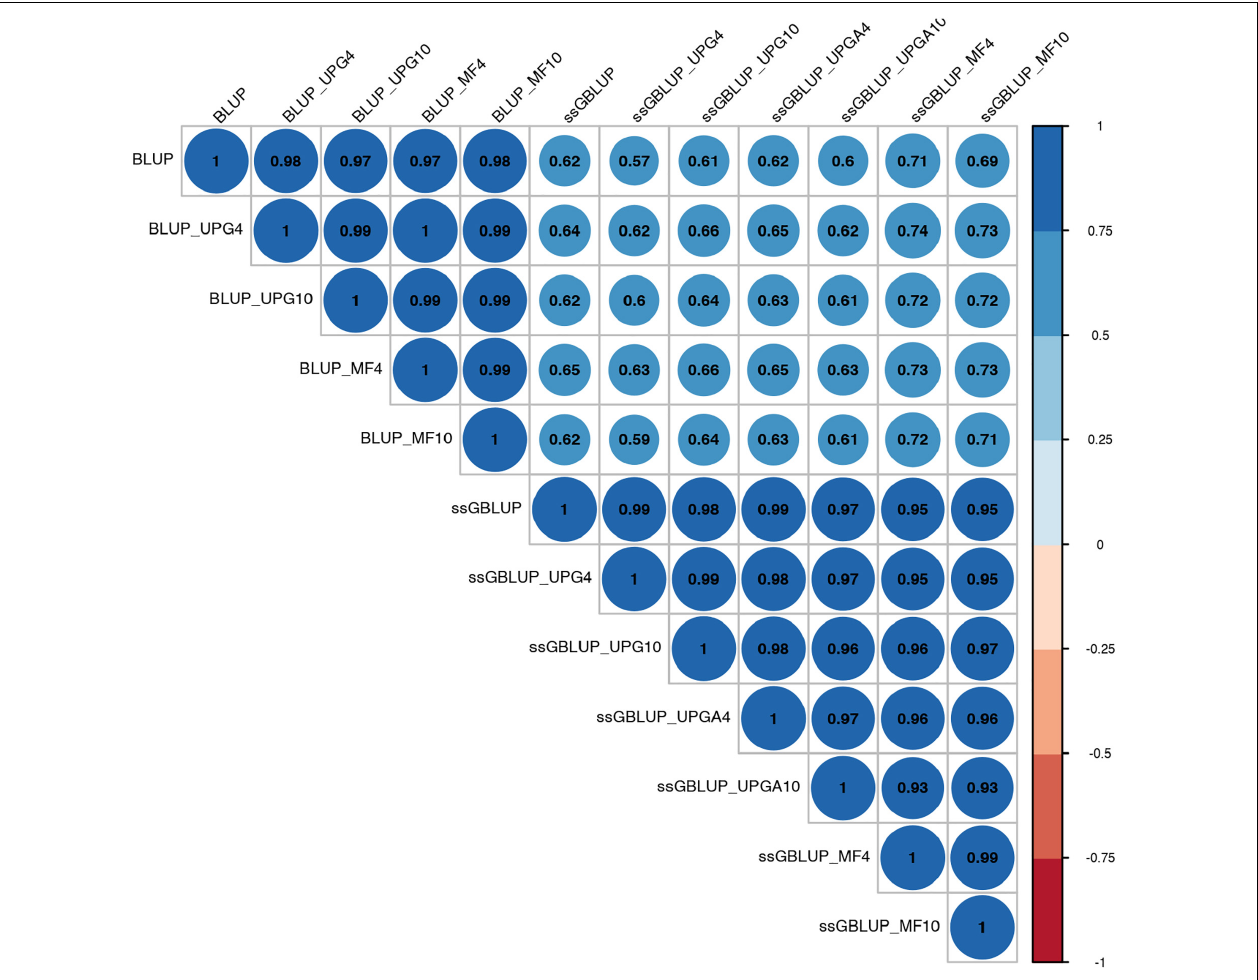
FIGURE 1 | Correlations between breeding values for scrotal circumference at 14 months of age estimated using various models with and without genetic